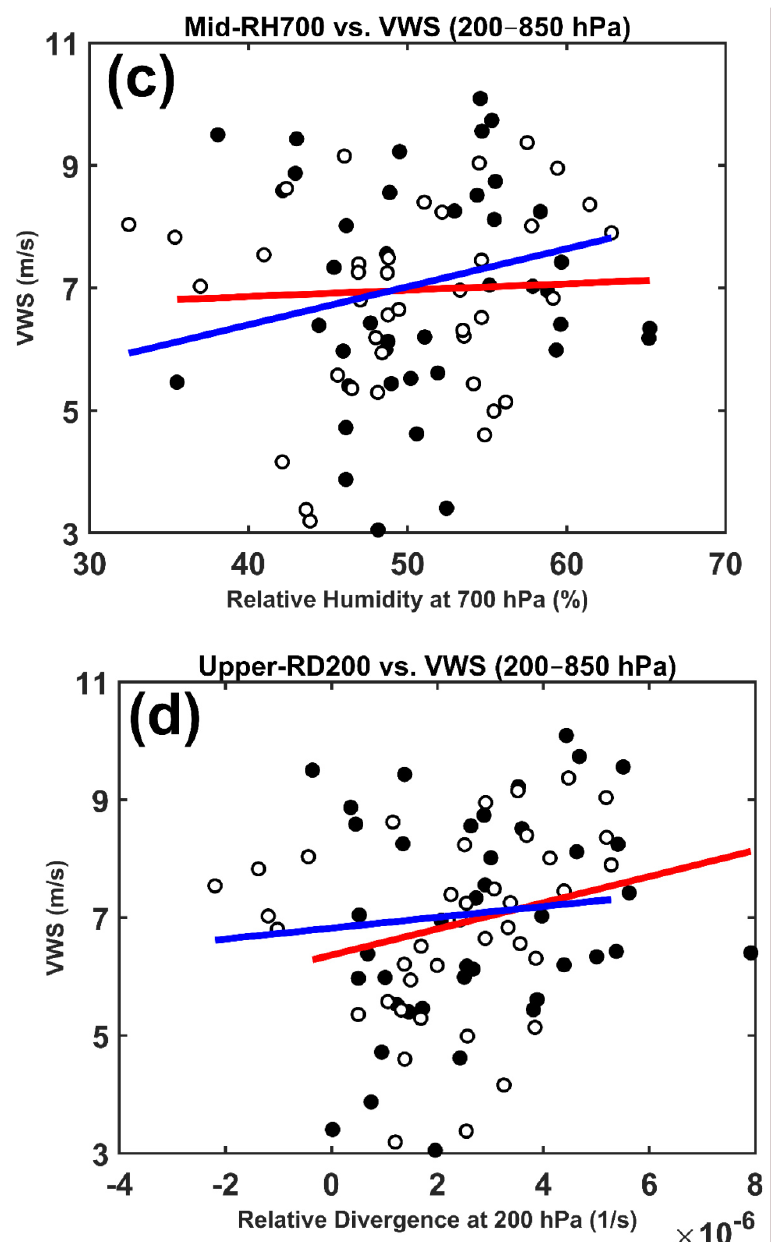
Figure 11. Relationship between VWS and SST ( a ), vorticity at 850 hPa ( b ), relative humidity at 700 hPa ( c ) and divergence at 200 hPa ( d ) for January (red line and black dots) and February (blue line and white